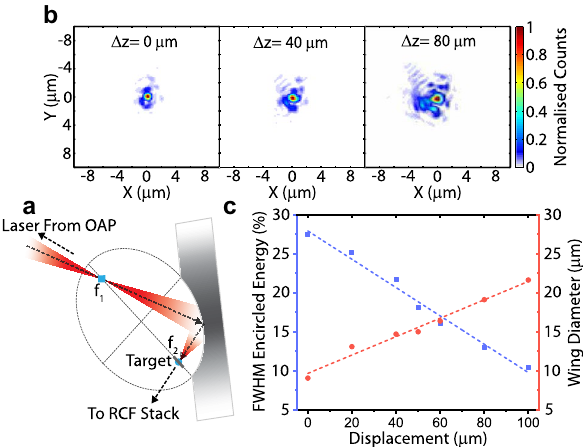
Figure 6. Focusing plasma mirror schematic and quantification of the focal spot wings. ( a ) Schematic of a focusing plasma mirror with the location of the target and direction radiochromic film (RCF) stack indicated. ( b ) Spatial-intensity distributions of the FPM output focal spot. ( c ) Encircled energy (blue) and spot wing diameter (red), as a function of OAP focus position displacement ( (cid:31) z) from optimal (at f 1 ) along the laser propagation direction. Optimised alignment, i.e. (cid:31) z = 0 µ m , has values of φ = 0.76 µ m and encircled energy=